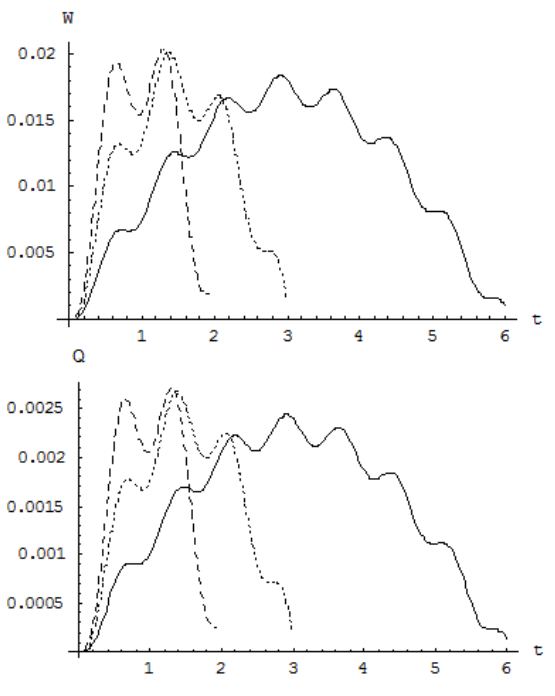
Figure 11: The influence of the speed for R = 150 m, e H = 3 m, e V = 1.20 m, and υ = 10 m/s ( ___ ), υ = 20 m/s (......), υ = 30 m/s ( - - - ).